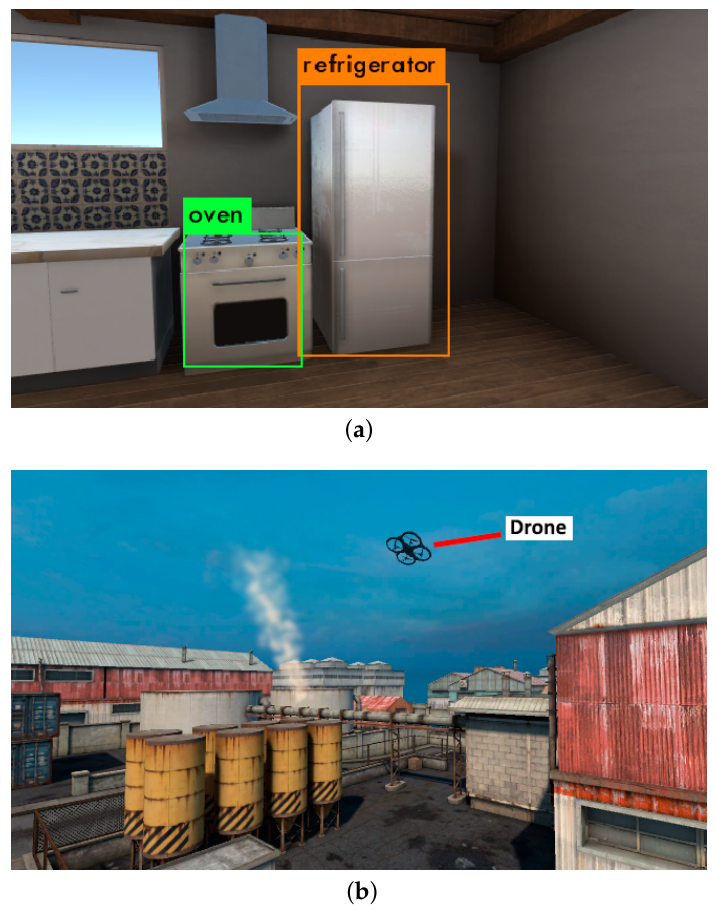
Figure 7. Examples of simulations carried out in with the proposed framework, as represented in the Unity engine. ( a ) The high degree of visual fidelity of the environments is specially relevant for semantics-based applications. In this example, the YOLO neural network [47] is able to recognize relevant items that could be sources of certain gas emissions. ( b ) Simulating the visuals of the gas plume is key for testing methods where the robots rely on vision to locate a gas